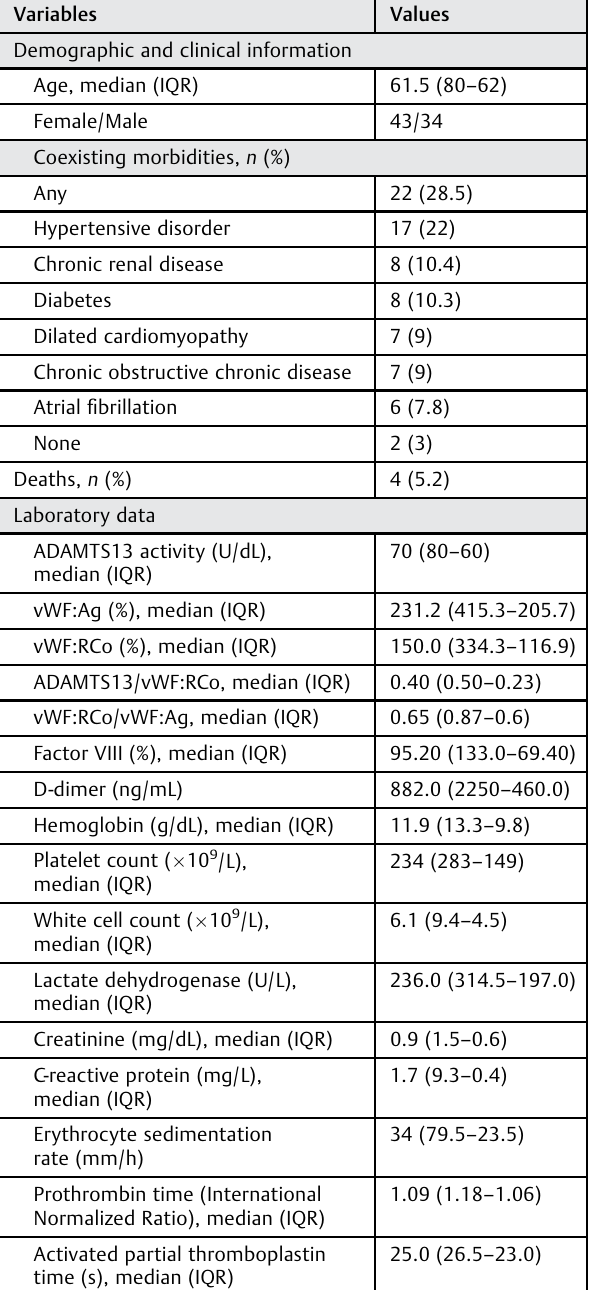
Table 1 Demographic/clinical information and laboratory